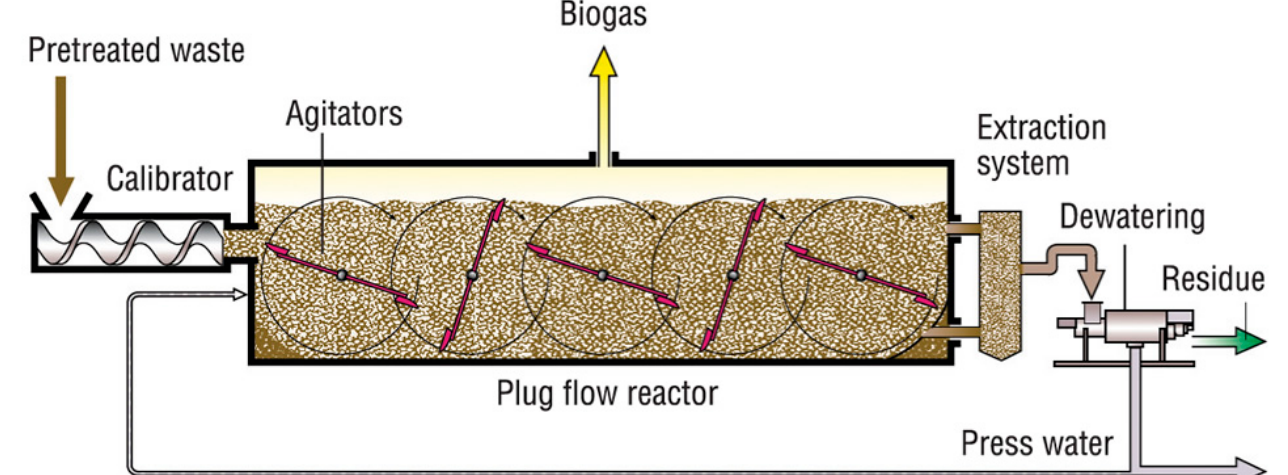
Figure 7. A modified plug-flow digester [42].